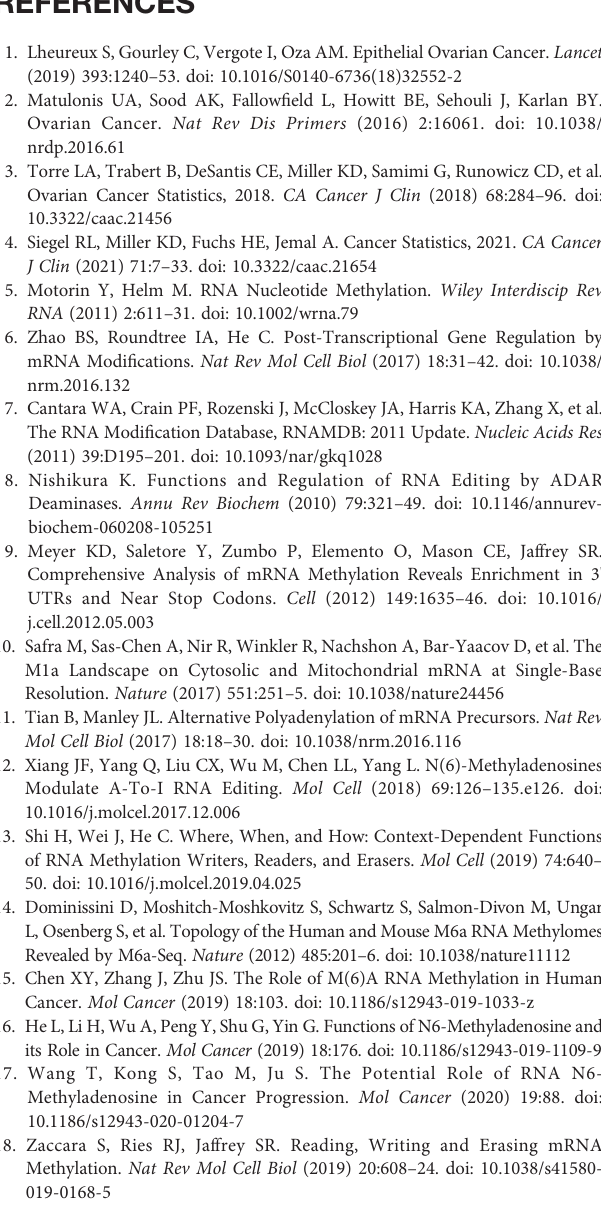
survival status. (C) Scatter plots showing the RMW score distribution and patient survival status. (D) Kaplan – Meier analysis of the OS between the two groups. (E) ROC curves to predict the sensitivity and speci fi city of 1-, 3-, and 5-year survival according to the RMW score. Supplementary Figure 10 | The expression level of 7 RMW score-related gens. (A – G) The expression level of ADNP, DYRK1B, GFPT2, MYCNOS, PLCH1, ZFHX4 and ZNF429 in OC cell lines. Supplementary Figure 11 | Strati fi cation analysis of the RMW score in OC. (A – C) The proportion of patient age, stage and survival status in high- and low- RMW score groups. (D – F) Boxplots for RMW score between different characteristics OC patients, including patient age, stage and survival status. (G – N) Kaplan-Meier curves depicted the survival difference between low and high RMW score in the strati fi ed analysis of OC patients.